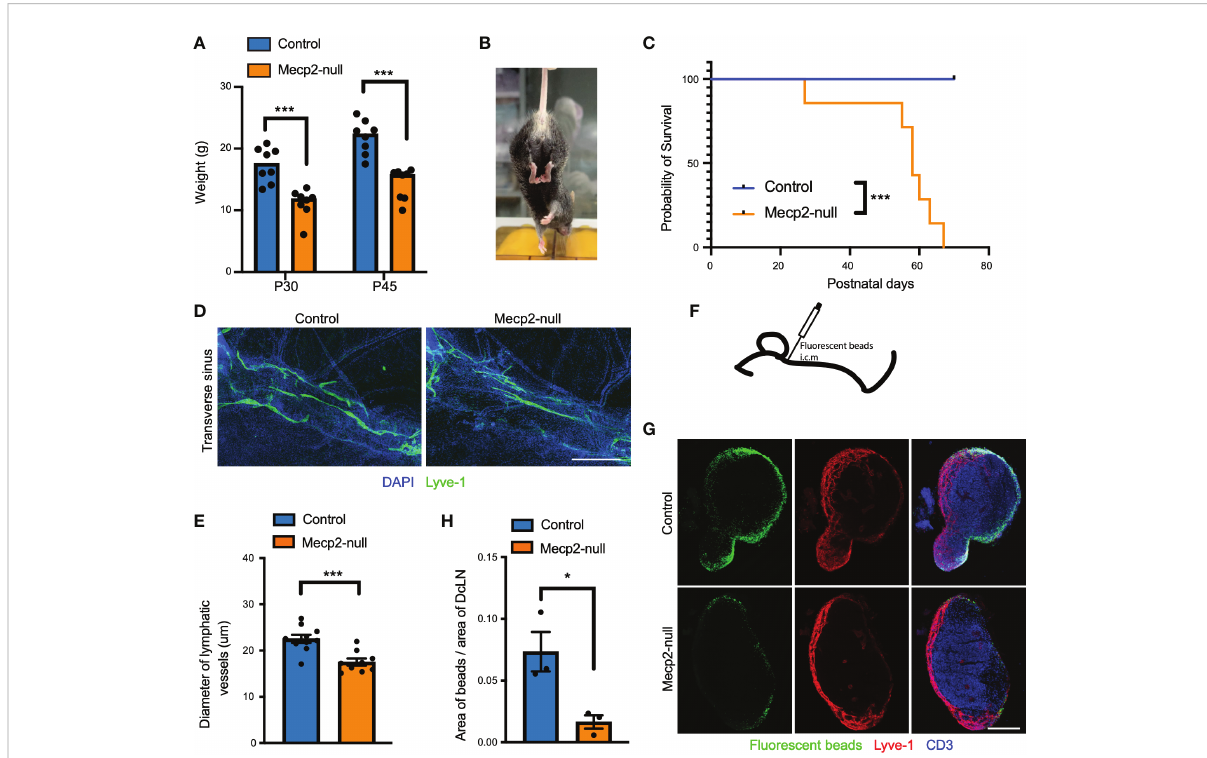
FIGURE 1 RTT-like phenotypes and de fi ciency of meningeal lymphatics in Mecp2 -null mice. (A) Bar graph showing retarded growth of Mecp2 -null mice compared to control at postnatal days 30 and 45 (n=8). P =0.0003 (P30) and P =0.00006 (P45), multiple t tests. (B) Representative images of hindlimb clasping in a Mecp2 -null mouse at postnatal day 45. (C) Kaplan-Meier survival plot for control and Mecp2 -null mice. (n=7 per group). P =0.0001 by the Log-rank test. (D) Representative images of the transverse sinus of dura maters with Lyve-1 (green) staining for 1-month-old control and Mecp2 -null mice. Scale bars: 500 m m. (E) Quanti fi cation of the diameter of Lyve-1 + lymphatic vessels (n=10 for control mice; n=9 for Mecp2 -null mice). Data represent the mean ± SEM. P = 0.0005, two-tailed unpaired t test. (F) Schematic of intracisterna magna injection with fl uorescent beads. (G) Representative images showing dCLNs with fl uorescent beads (green), Lyve-1 (red), and CD3 (blue) staining in control and Mecp2 -null mice. Scale bars: 250 m m. (H) Quanti fi cation of the percentage of fl uorescent beads coverage of the dCLNs from control and Mecp2 -null mice (n=3 per group). Data represent the mean ± SEM. P = 0.0281, two-tailed unpaired t test. *p < 0.05, ***p <